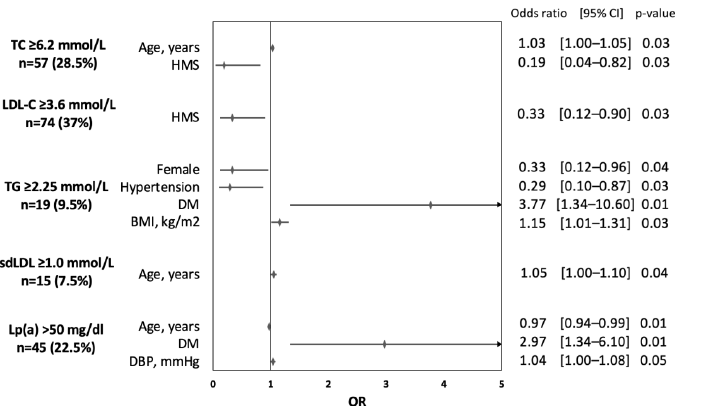
Figure 1. Determinants of elevated lipid parameter based on the results of multivariate analyses. Rates of patients with highly elevated lipid parameters are reported in round brackets. (HMS—higher material status; DM—diabetes mellitus; BMI—body mass index; DBP—diastolic blood pressure.)